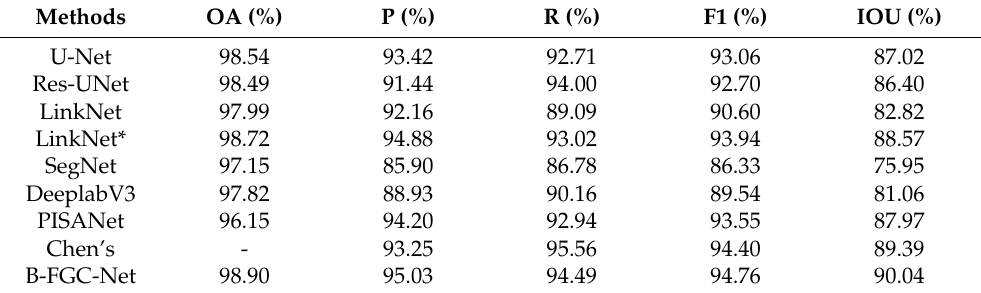
Table 3. Accuracy evaluation results of different methods on the WHU building dataset. PISANet and Chen’s model are implemented by [56] and [4] respectively. ‘-’ denotes that the paper did not provide relevant